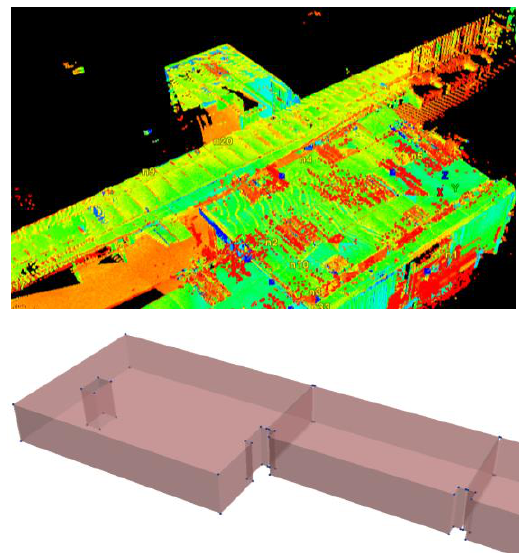
Figure 3. Point Cloud (above) to 3D model